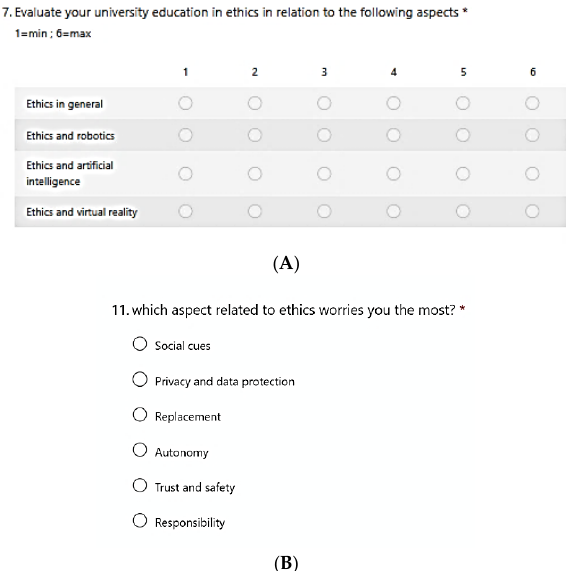
Figure 3. ( A ) Survey section ( Likert’s scale ) dedicated to questions on academic training. ( B ) The choice question with ethical aspects of